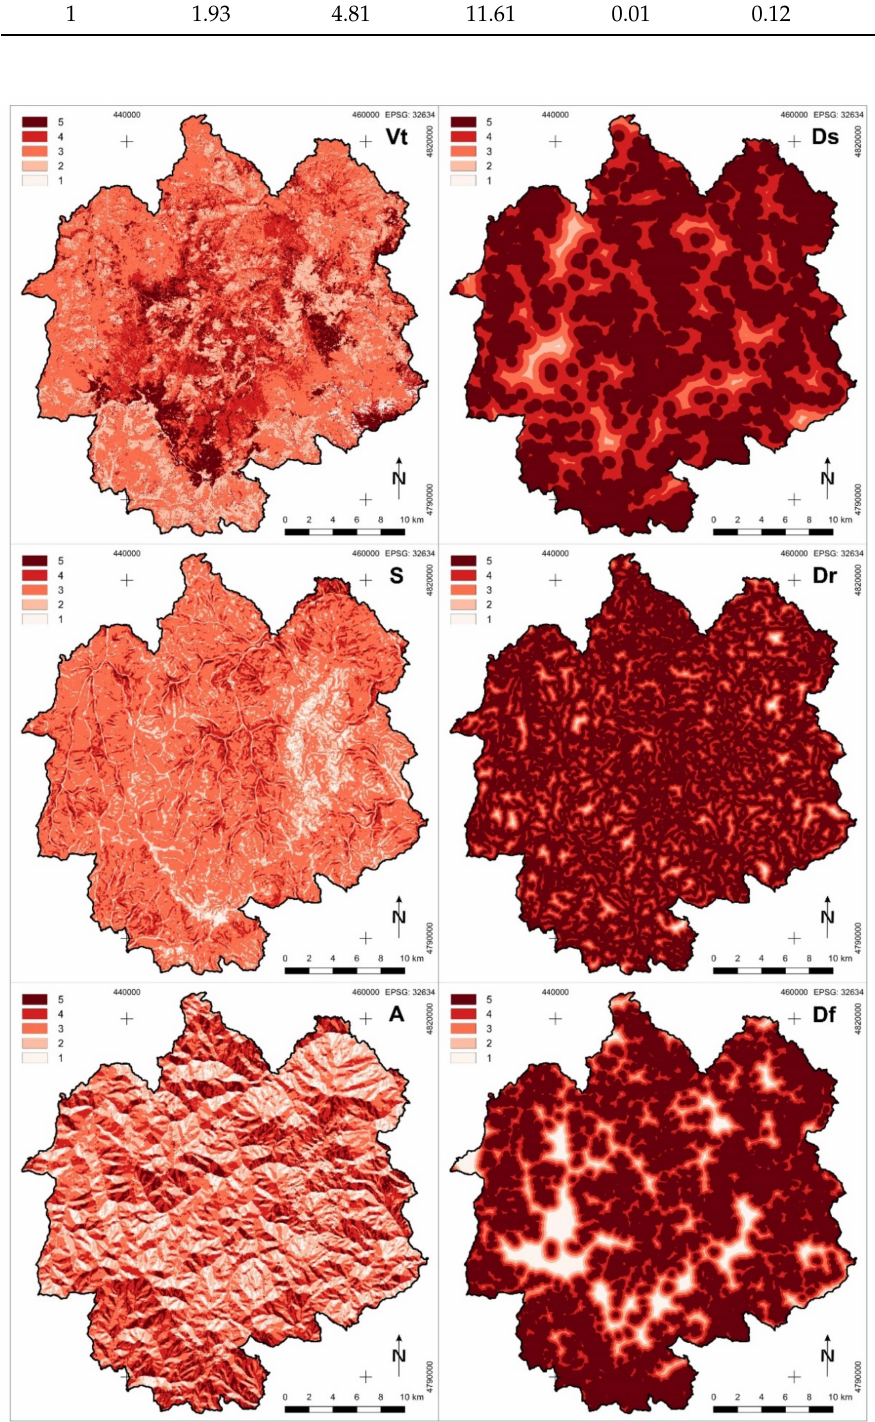
Figure 5. Spatial distribution of classes in factors in Nature Park